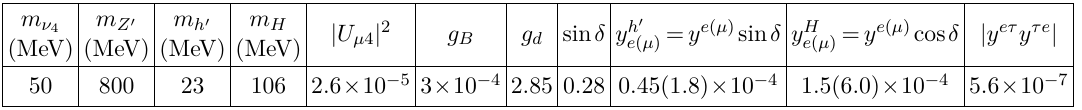
Table 1 . Benchmark parameter values used for event generation in MB and for calculating the muon and electron g − 2